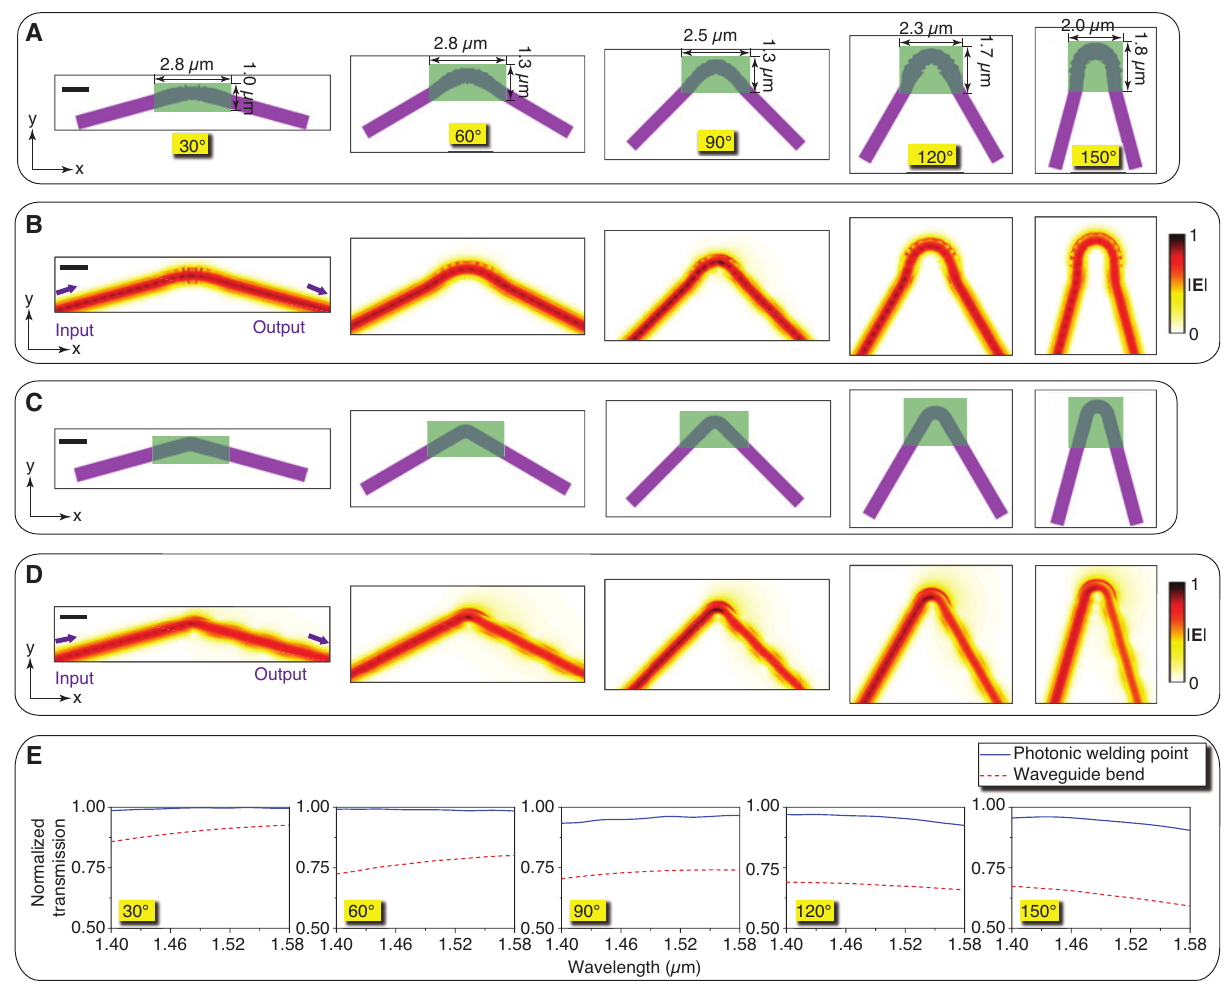
Figure 2: Designs and simulation results of the photonic welding points and waveguide bends. (A) Optimized structures of photonic welding points connecting two waveguides with bending angles of 30 ° , 60 ° , 90 ° , 120 ° , and 150 ° . (B) Simulated electric field profiles of the TE mode at 1.55 μ m transmitting through the photonic welding points. (C) Schematic of waveguide 0 bends connecting two waveguides with bending angles of 30 ° , 60 ° , 90 ° , 120 ° , and 150 ° . The inner radius of all waveguide bends is 0.15 μ m. (D) Simulated electric field profiles of the TE mode at 1.55 μ m transmitting through the waveguide bends. The purple arrows indicate the 0 light input and output directions. (E) Normalized transmission spectra of photonic welding points (blue solid lines) and waveguide bends (red dashed lines) connecting two waveguides with bending angles of 30 ° , 60 ° , 90 ° , 120 ° , and 150 ° . (A–D) Scale bars represent 1 μ